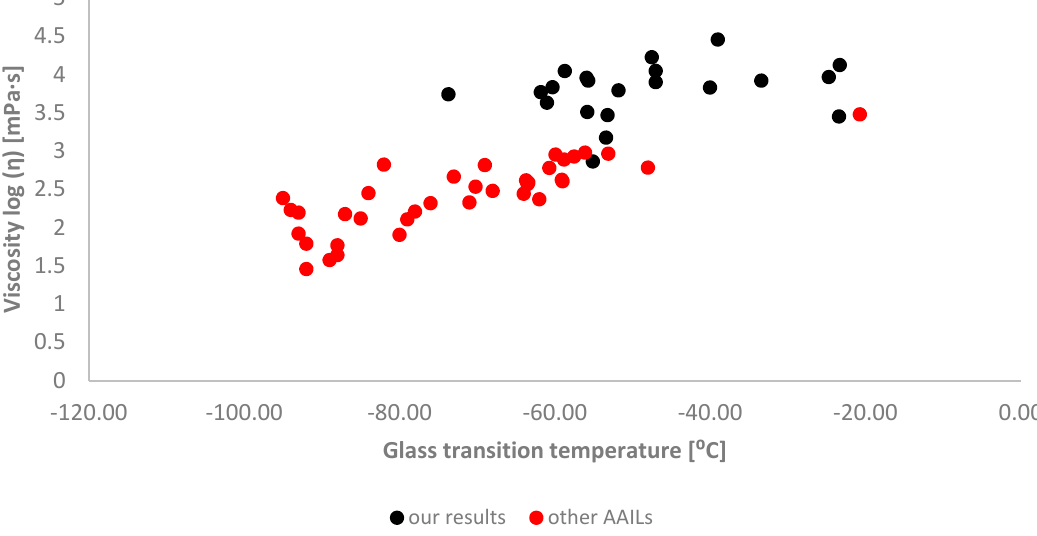
Figure 6. Relation between viscosity (25 °C) and glass transition temperature (T g ) of amino acid ionic liquids.